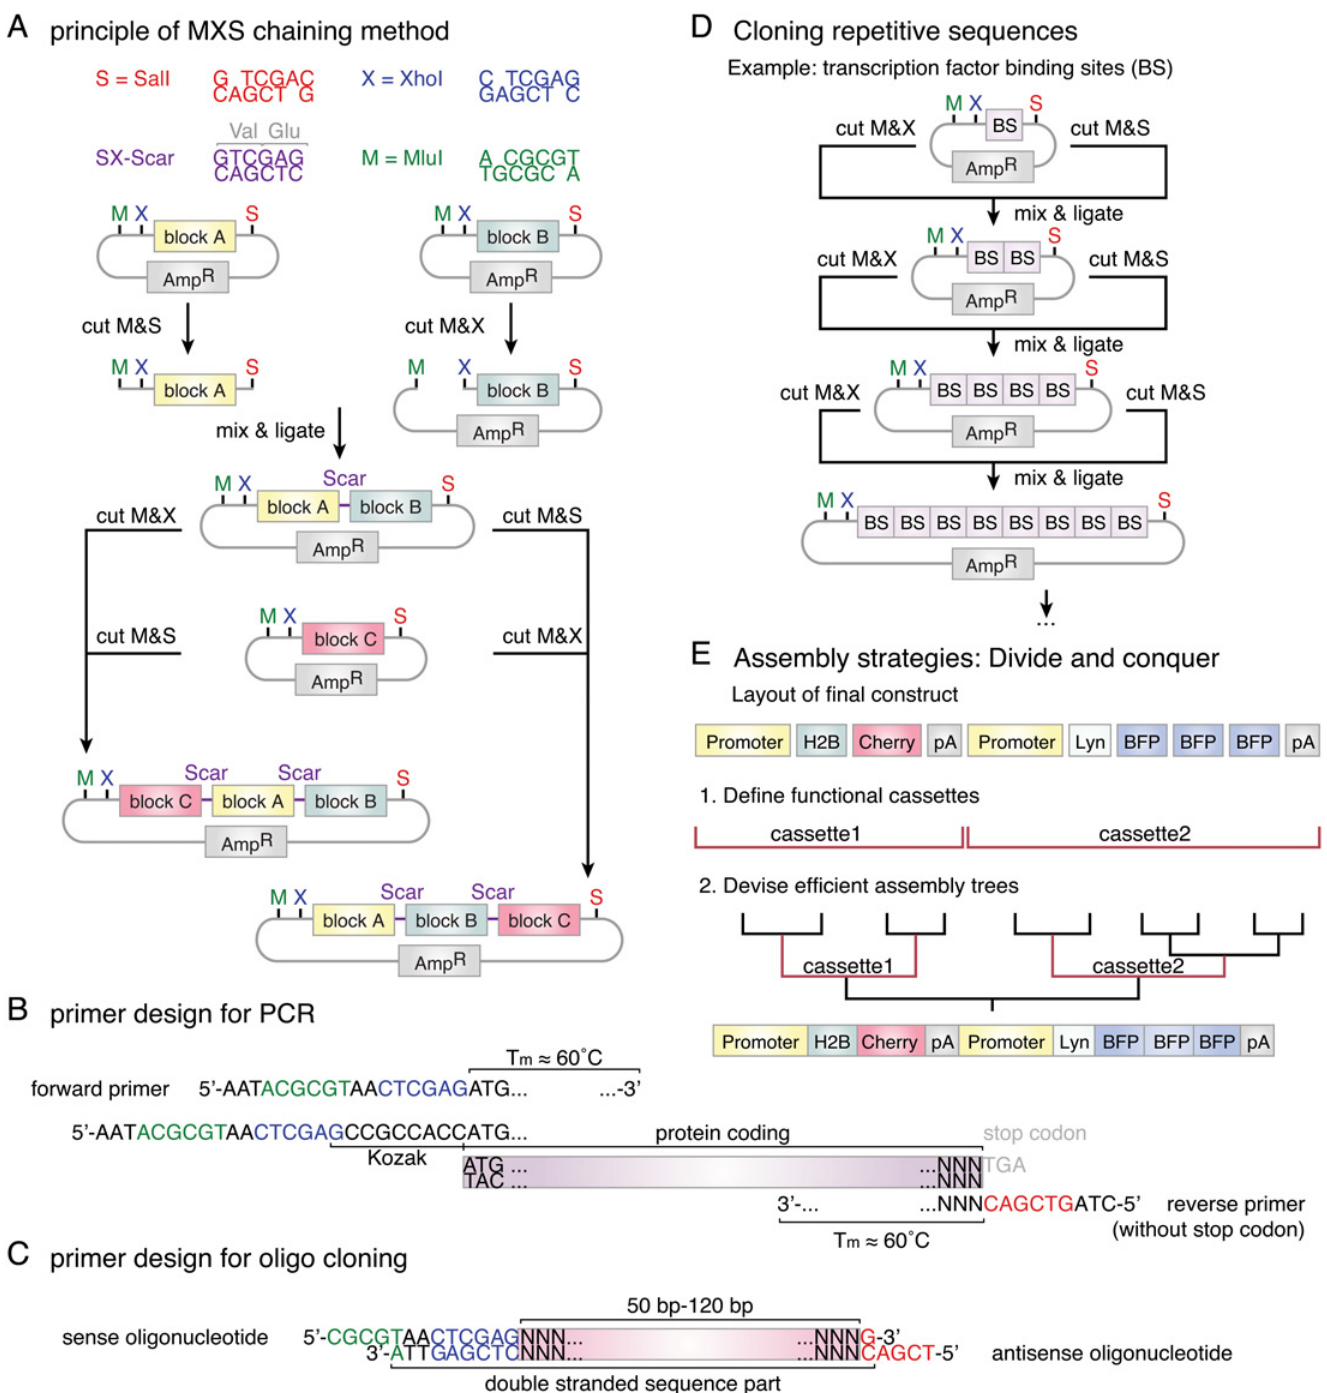
Fig 1. Scheme of the MXS-chaining strategy. (A) MluI (M), XhoI (X) and SalI (S) recognition sites are highlighted in green, blue and red, respectively. SalI- and XhoI-overhangs form a compatible pair whose cohesive ends give rise to a translatable scar (coding for valine and glutamic acid) upon ligation. Individual building blocks can be chained together in the desired order, with the MS-digested building block forming the 5 ’ -part and the MX-digested building block the 3 ’ -part of the new chaining module. As the XS-Scar is not cut by any of the restriction enzymes used in the chaining system the original pattern of restriction sites is recreated, which allows the reiteration of the chaining procedure. (B) New building blocks can be isolated from plasmid, genomic or cDNA by PCR. The melting temperature (Tm) of the template binding part of pairs of primers should not differ by more than 1K and be close to 60°C. 5 ’ -extensions on forward and reverse primers enable direct subcloning of the PCR product into the MXS-chaining context. For protein coding sequences, the maintenance of